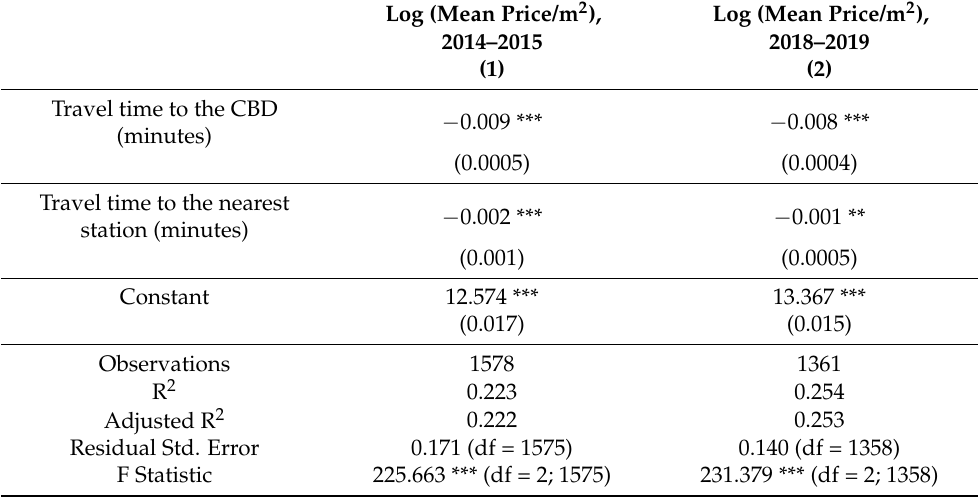
Table 4. Regression results of travel time to the nearest station and CBD on flat